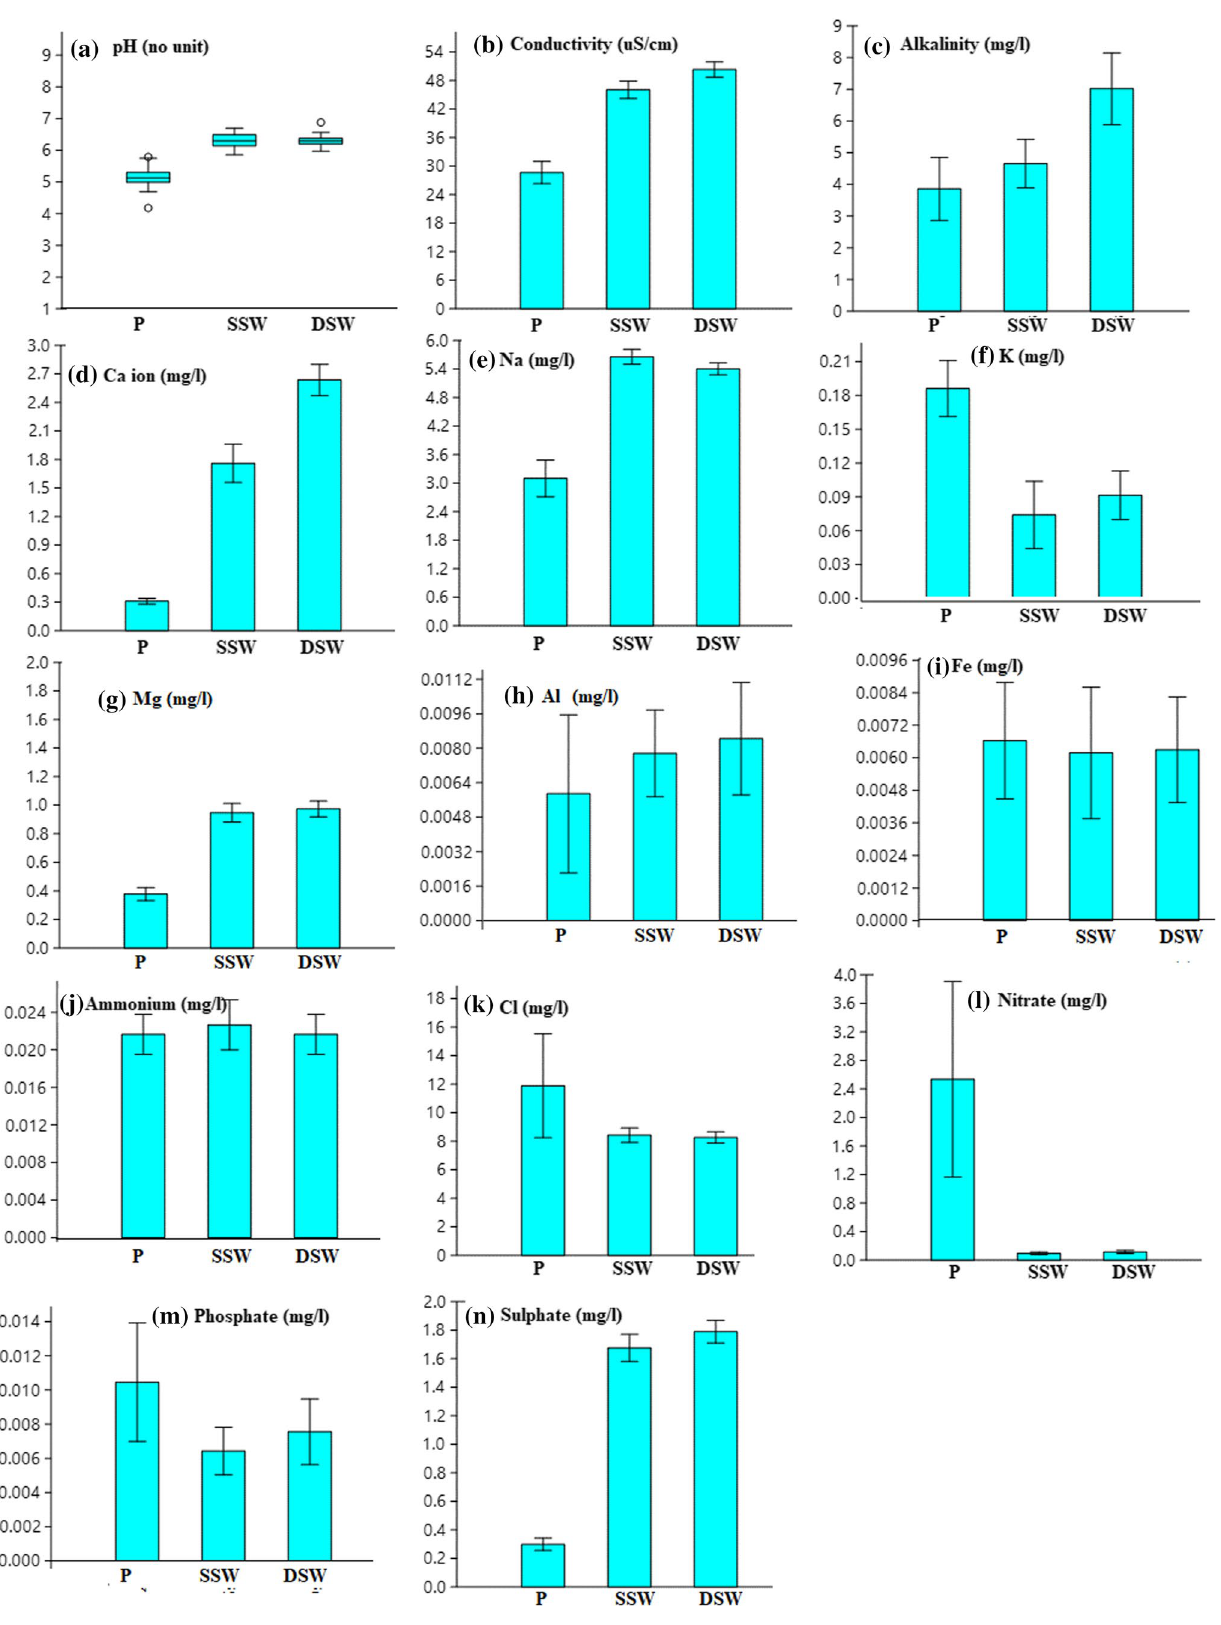
Fig. 3 Comparison of selected variables between precipitation and soil water